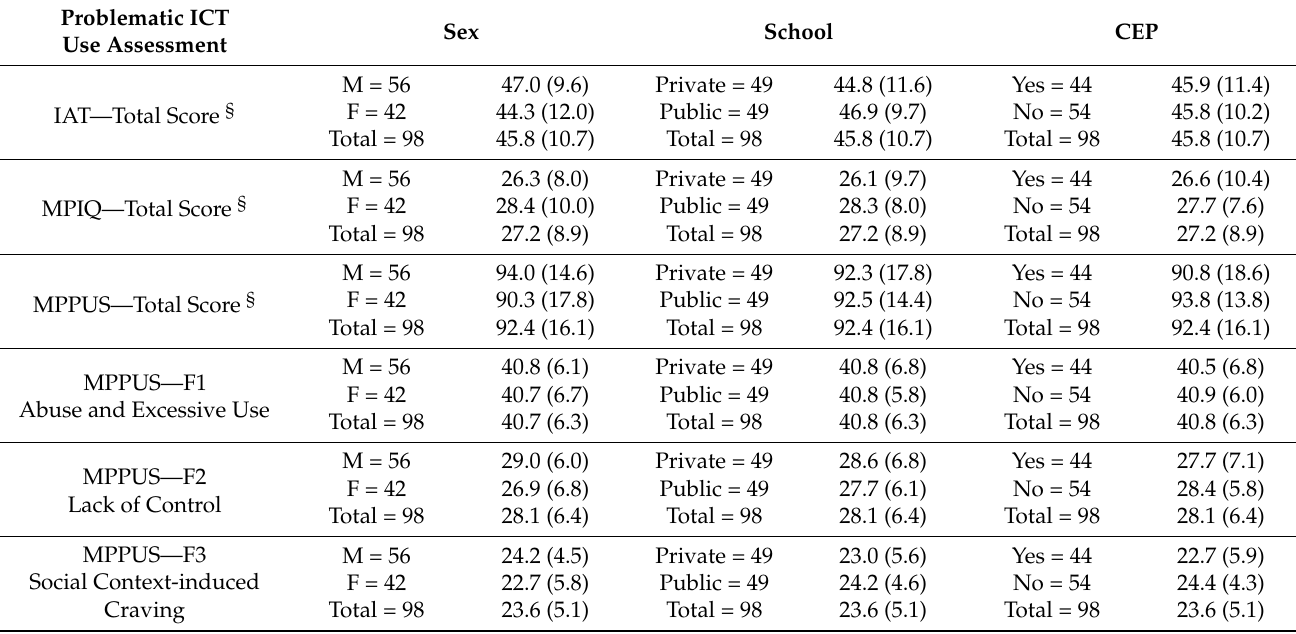
Table 4. Mean and standard deviation of the variables used to assess DMPU and their differences by sex, school and participation in